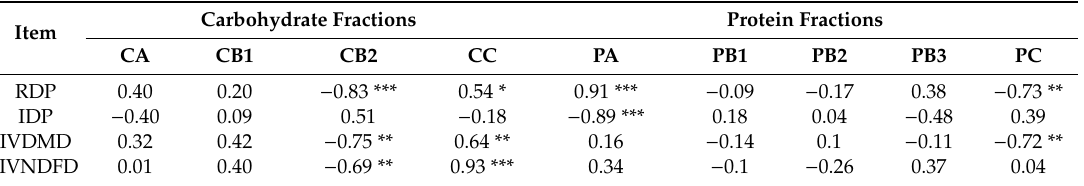
Table 4. Correlation coe ffi cients between in vitro digestibility and CNCPS Carbohydrate and Protein fractions in the oil-seeds